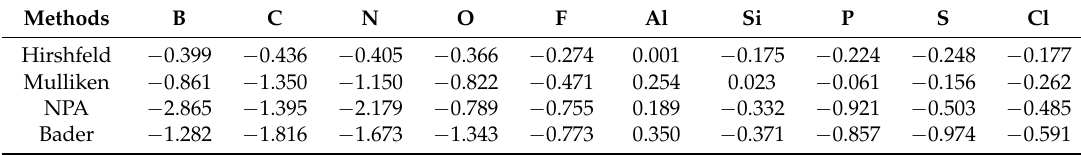
Table 2. Theoretical atomic charges on X atoms (X = B, C, N, O, F, Al, Si, P, S,